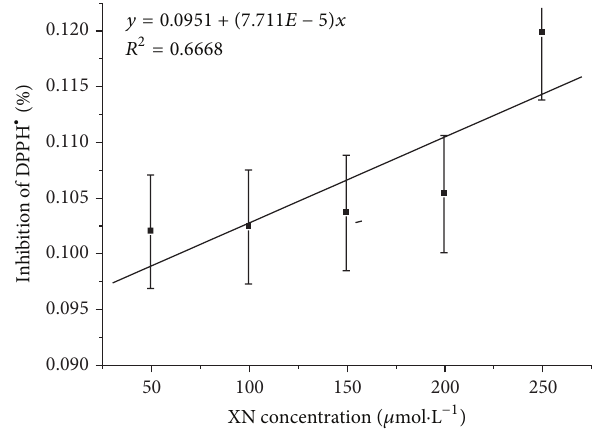
Figure 5: A linear correlation curve between Xanthohumol con- centration and DPPH ∙ inhibition percentage rate. 𝑌 = 0.0951 + (7.711𝐸 − 5)𝑋 and 𝑅 2 = 0.6668 ( 𝑛 = 3 ).